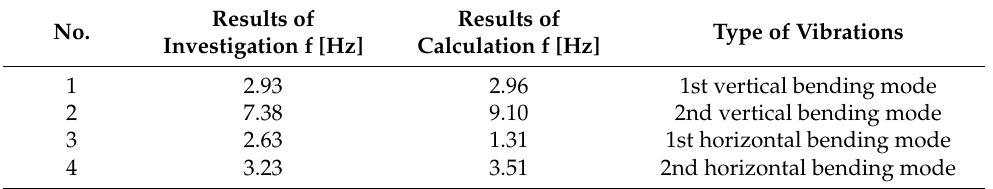
Table 5. Calculated and identified frequencies of the deck’s vibrations.